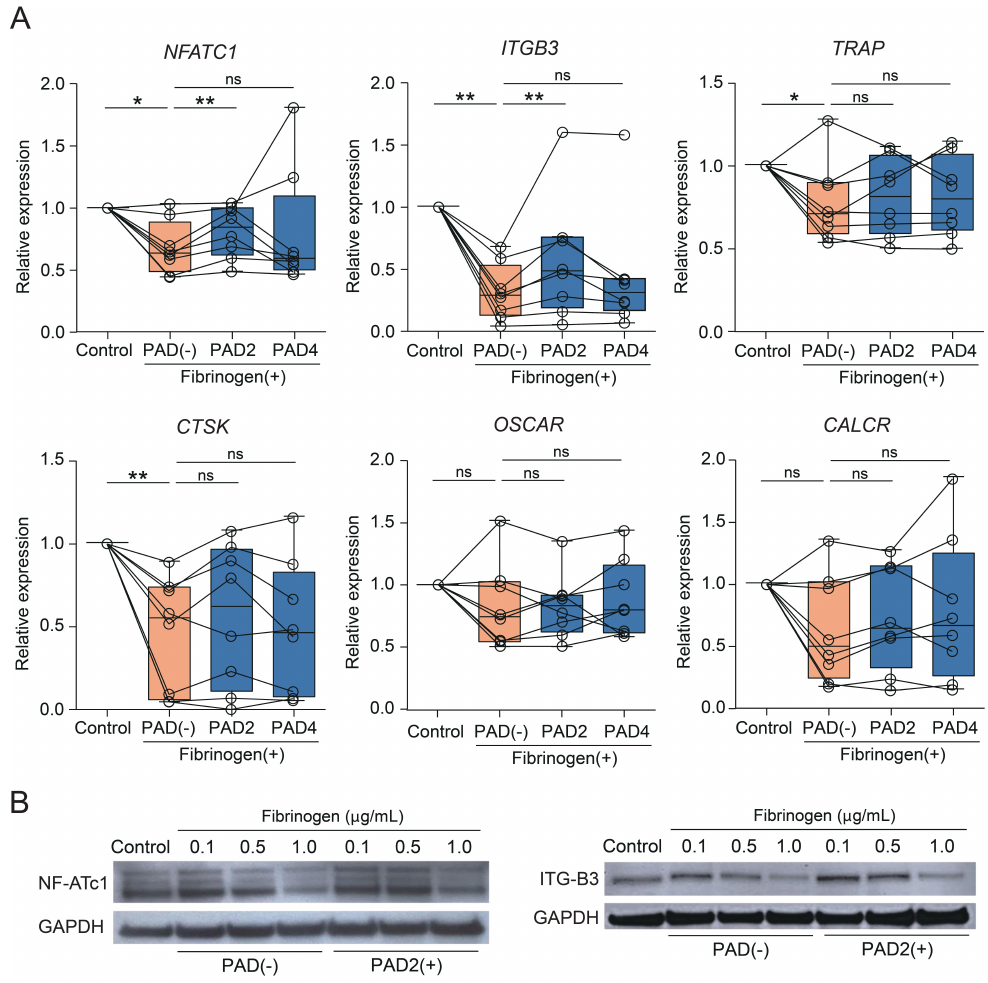
Figure 3. Gene and protein expression in osteoclasts in the presence of PAD. ( A ) Real-time PCR of cells cultured in the absence or presence of PAD2 or PAD4 at a dose of 1.0 µ g / mL ( n = 8). * p < 0.05; ** p < 0.01; ns—not significant. Individual values are plotted, and error bars represent SD. ( B ) Western blot of NF-ATc1, β 3-integrin, and GAPDH. M-CSF and RANKL were supplemented in the control